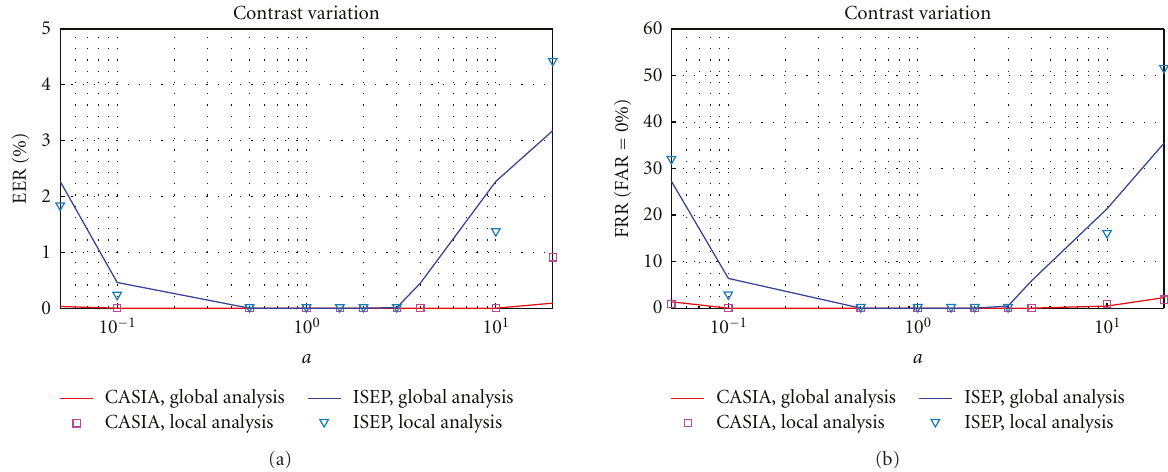
Figure 17: (a) EER and (b) FRR (FAR = 0%) as a function of the contrast variation, measured on CASIA and ISEP databases.